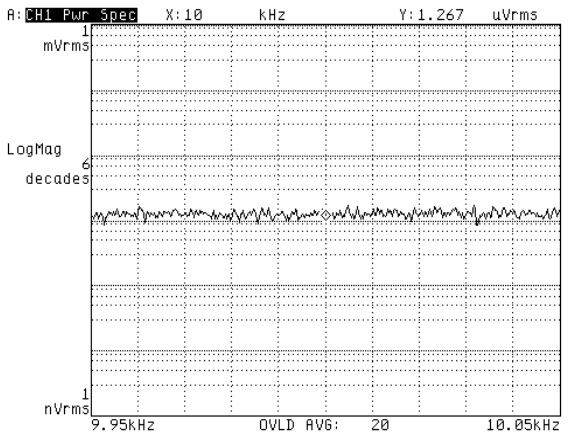
Figure 16. Output noise of the implemented C/V converter.